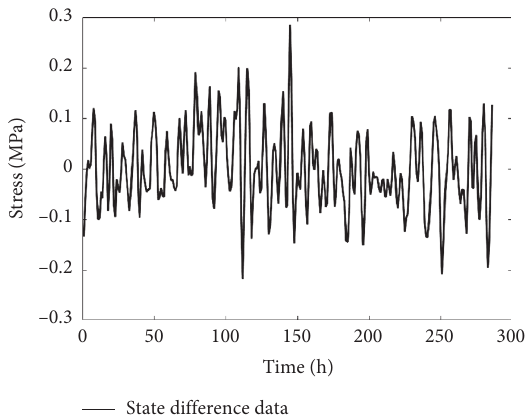
Figure 8: State change data (or state difference data).